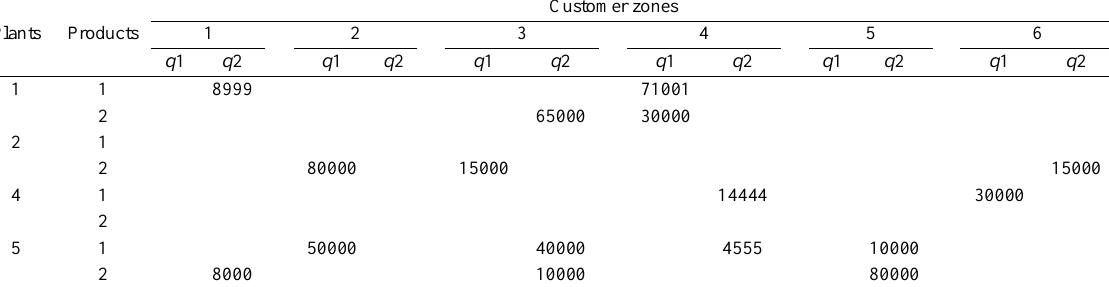
Table 12. Market share for each plant